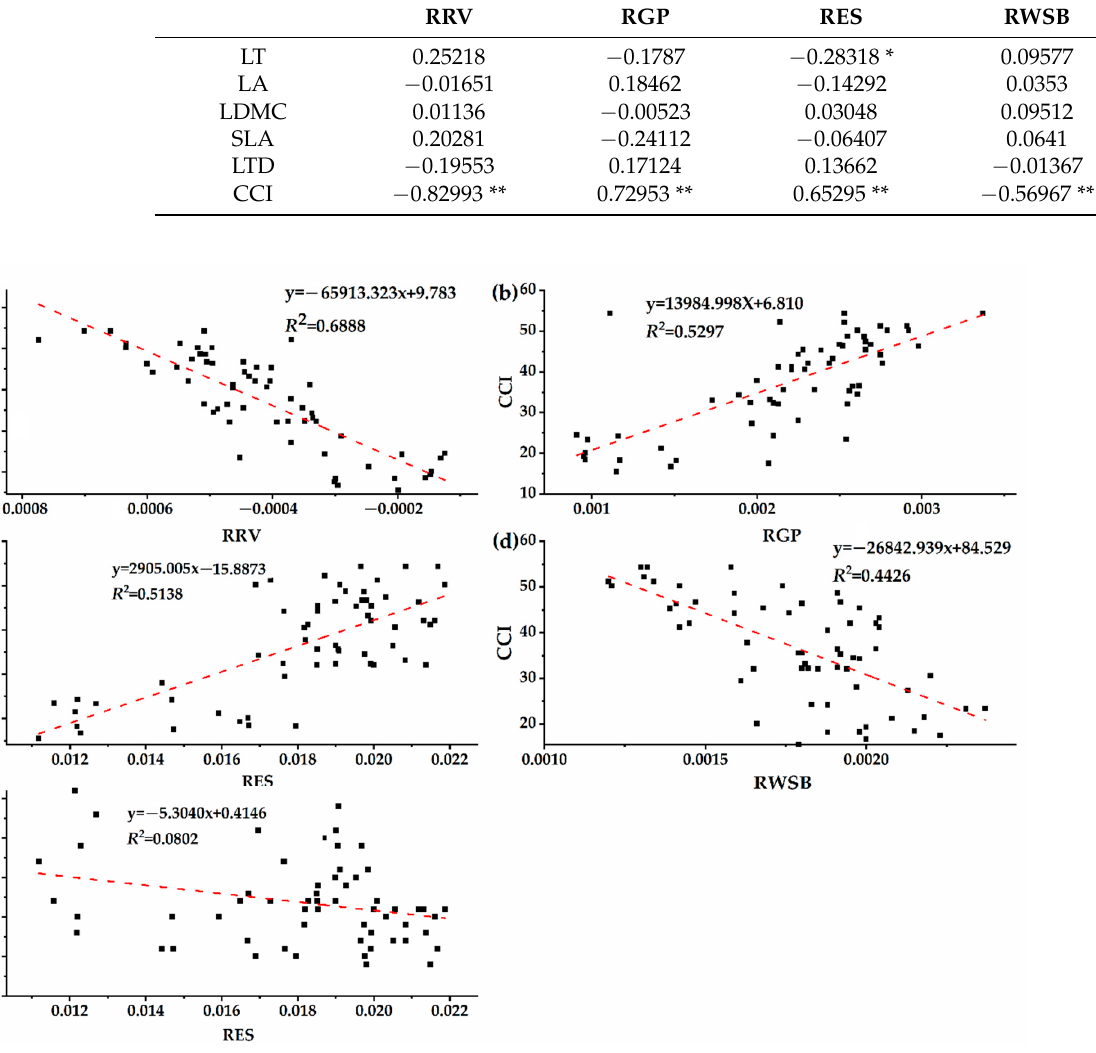
Figure 7. Linear correlation between functional traits and spectral parameters. ( a ) the reflection of red valley (RRV) and CCI, ( b ) the reflectance of green peak (RGP) and CCI, ( c ) the slope of red edge (RES) and CCI, ( d ) the reflection of water stress band (RWSB) and CCI, ( e ) the reflectance of green peak (RGP) and LT.